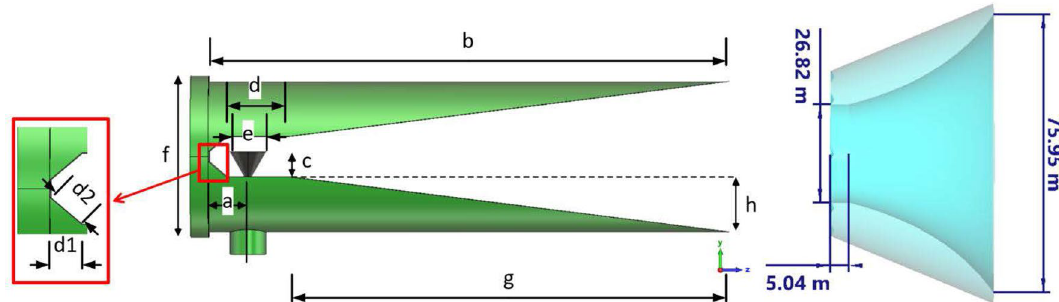
Figure 8. Antenna feed along with its wideband adapter. The conical waveguide section of the horn is not shown in this figure to better represent the transition section.